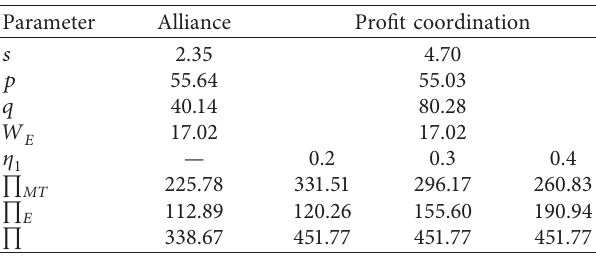
Figure 3: Sensitivity of the unit delivery price in semicentralized model